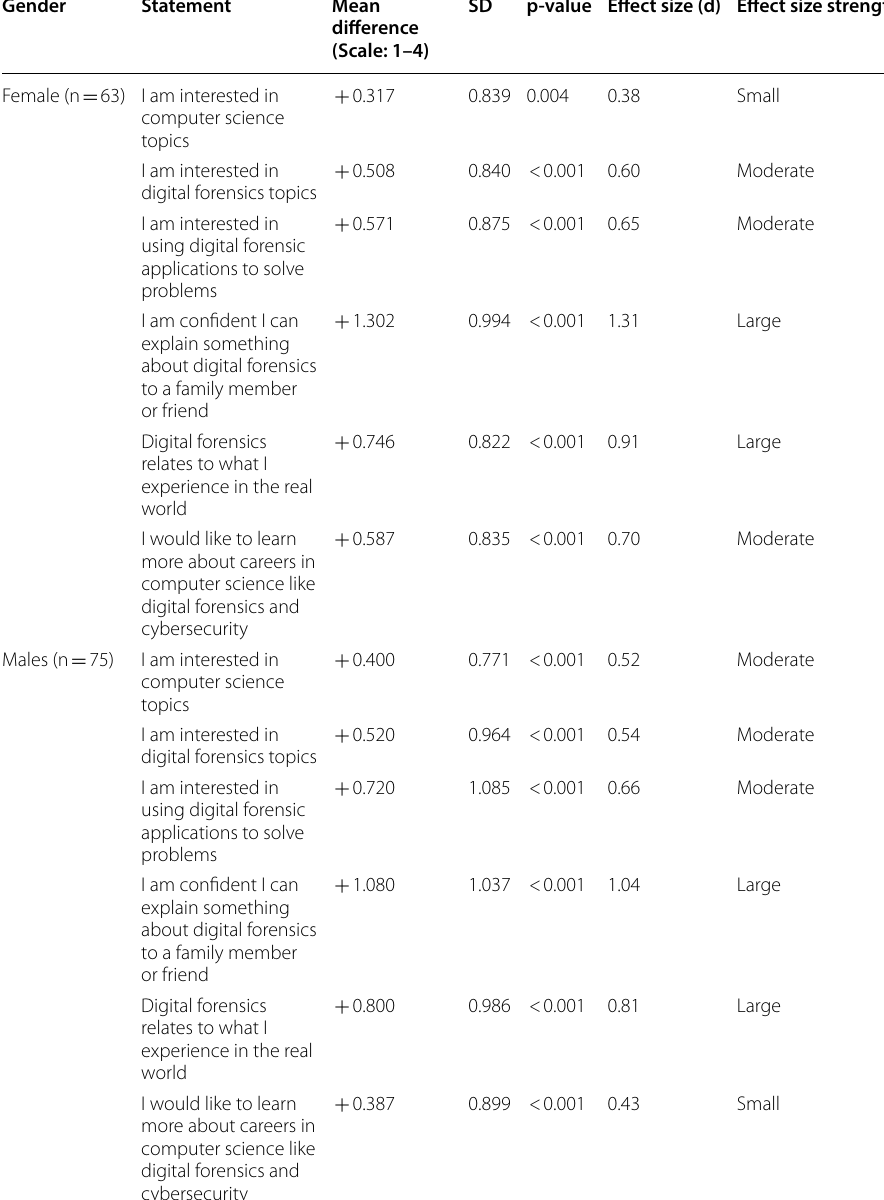
Table 3 Paired-samples t-test comparison by gender of students’ understanding of and interest in digital forensic science and related careers based on retrospective pre-post survey questions